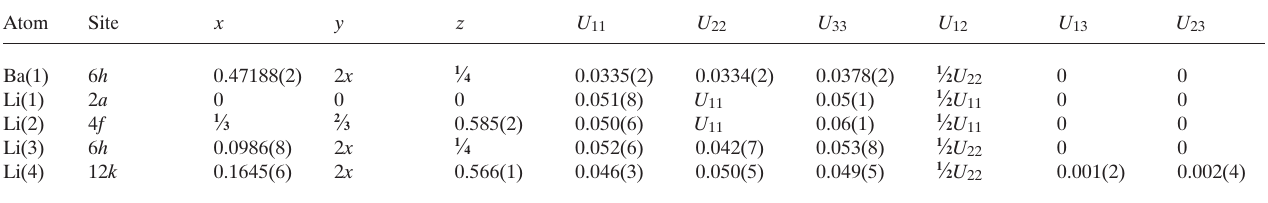
Table 2. Atomic coordinates and displacement parameters (in Å 2 ) .